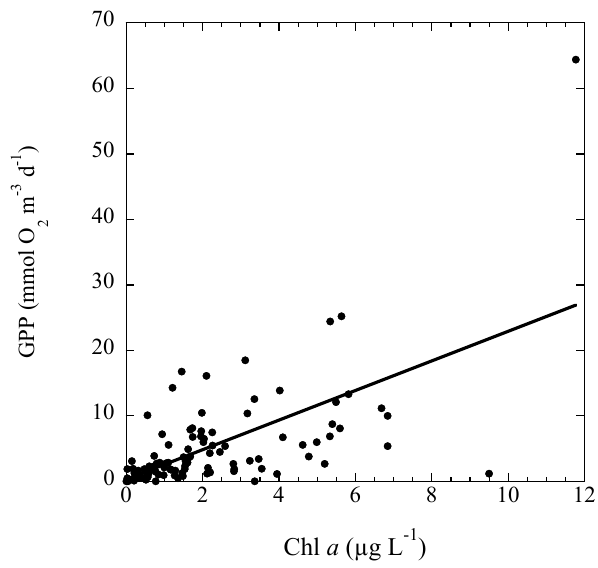
Fig. 7. The relationship between gross primary production (GPP) and chlorophyll a concentration. The solid line shows the fitted re- gression equation GPP (mmolO 2 m − 3 d − 1 ) = 0.30 + 2.26( ± 0.29) chl a (µgchl a L − 1 ) ( R 2 = 0.38, p < 0.0001, N =